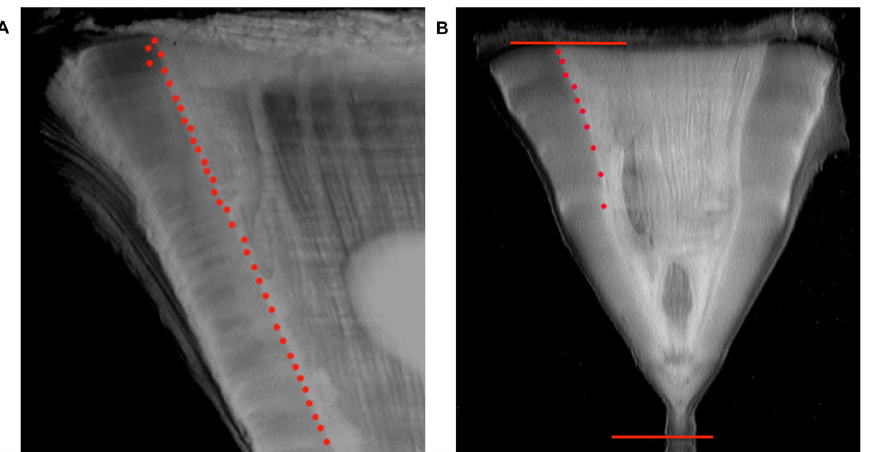
Figure 1. Photomicrographs of sectioned vertebrae. A) Upper section of vertebra taken from WS105. B) WS 100 vertebra; first dot is the birth band. Visible band pairs are marked by dots on the corpus calcareum. The lines indicate the vertebral radius (16.6 mm). Vertebral radius is measured at the angle of the vertebra where the intermedialia meets the corpus calcareum.